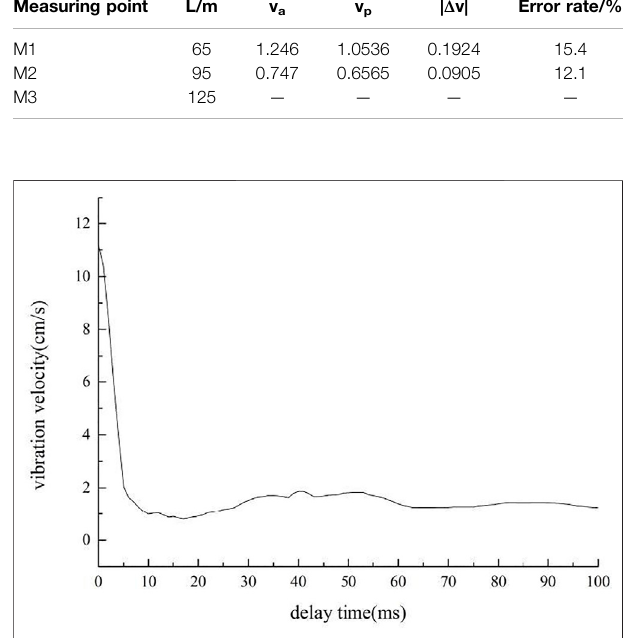
FIGURE 5 | Relationship curve between different delay times and maximum blasting particle vibration